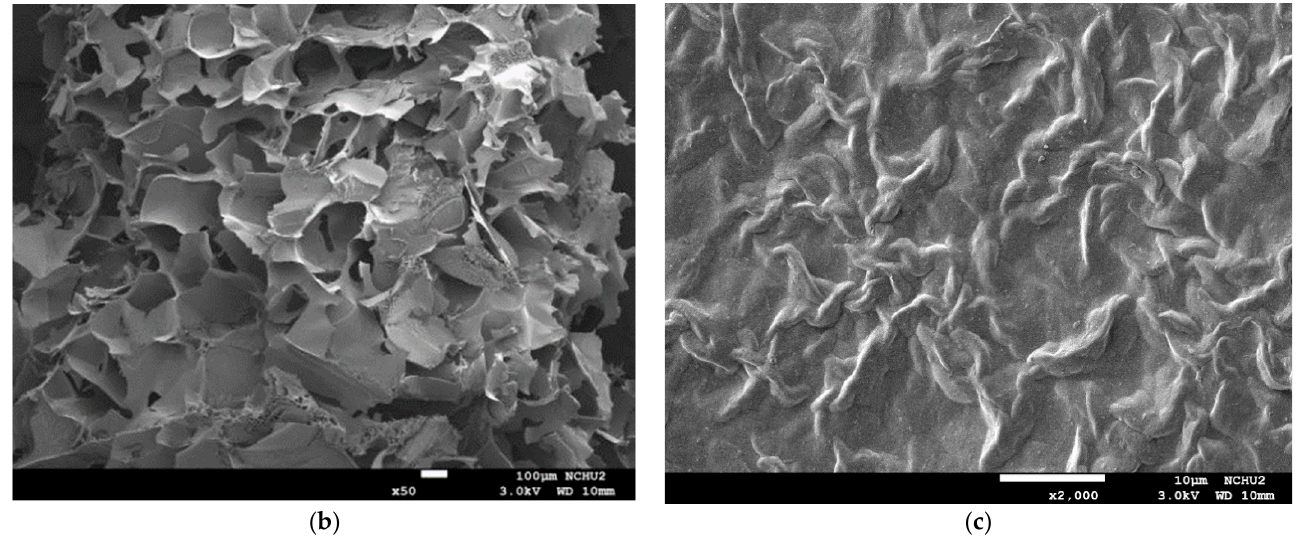
Figure 9. Scanning electron microscopic images of lyophilization sample matrices: ( a ) Sample with magnified levels of 100× and 200× for the samples of XG0.5, AP2, AP2Sugar5, AP2Ca5, AP1.8XG0.2, and AP2Salt5, respectively; ( b ) The 50× image of AP2Suagr5 evidencing a hive-like structure corresponding to 200× level in ( a ); ( c ) The 2000× image of AP2Salt5 evidencing possible isolated salting particles.